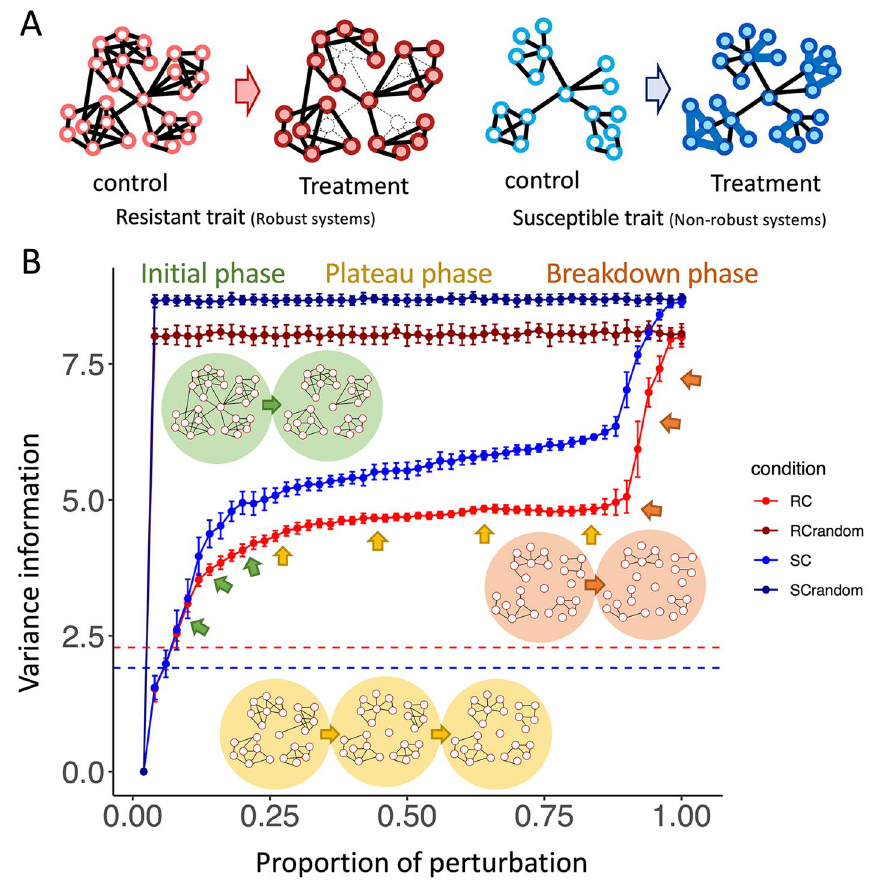
Figure 2. The hypothetical models of GCN network topology in resistant and susceptible trait and computational testing; ( A ) Schematic models of resistant (left) and susceptible (right) trait responses to perturbation proposed from the topological parameters investigated in each condition. Nodes represent genes in the network. Filled and unfilled nodes are genes under treatment and control conditions, respectively. Associations between genes are represented as lines; bold lines indicate associations occurring in the network, while dashed lines are associations that are missing from the previous network. ( B ) Line graph demonstrating changes in the gene community during perturbation, categorized into three different phases: initial (green), plateau (yellow) and breakdown phases (orange). The x-axis represents the magnitude of perturbation, which is the number of edges sequentially removed from the total number of edges. The y-axis represents the mean variance information (VI) of 30 repetitions. Error bars represent the standard deviation of 30 repetitions. Dashed lines (internal control) represent the VI calculated to reconcile the effect of the network size on the comparison. The higher the perturbation at the intercept of internal control line on VI is, the more robust the network